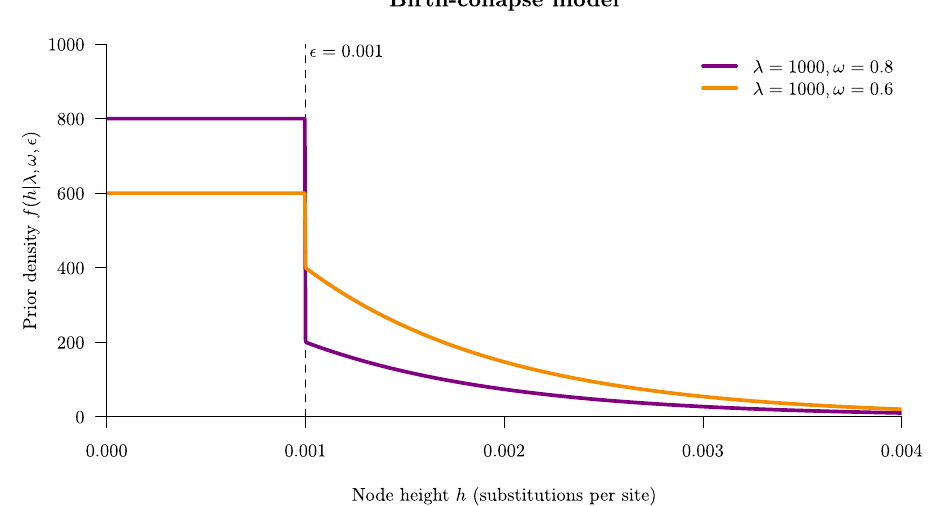
Fig. 1 The birth-collapse tree prior distribution with Yule model birth rate λ and collapse probability ω . Taxa whose common ancestral species lineage falls below threshold ϵ are “ collapsed ” into a single species (or cluster), while species tree nodes above ϵ are sampled from an exponential distribution with rate λ 40